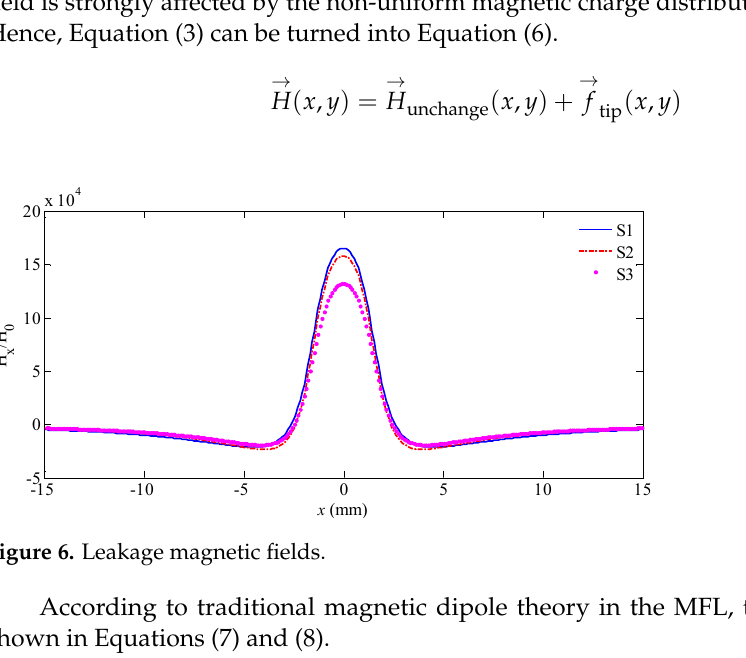
Figure 6. Leakage magnetic fields.